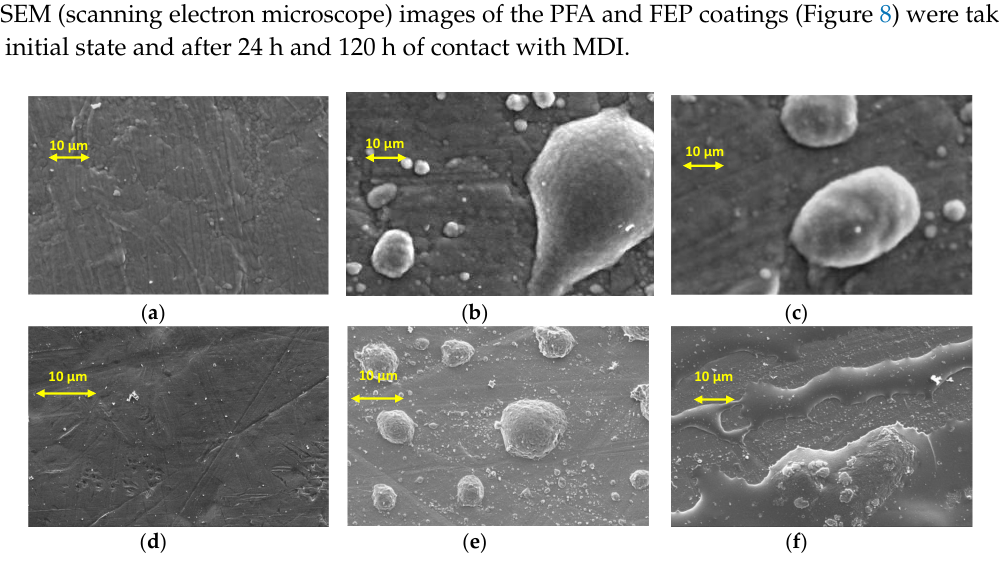
Figure 8. Images obtained by SEM, after contact with 4,4´methylene diphenyl diisocyanate (MDI), of TF-3635 (FEP): ( a ) reception; ( b ) after 24 h; and ( c ) after 120 h, and of TF-76521 (PFA): ( d ) reception; ( e ) after 24 h; and ( f ) after 120